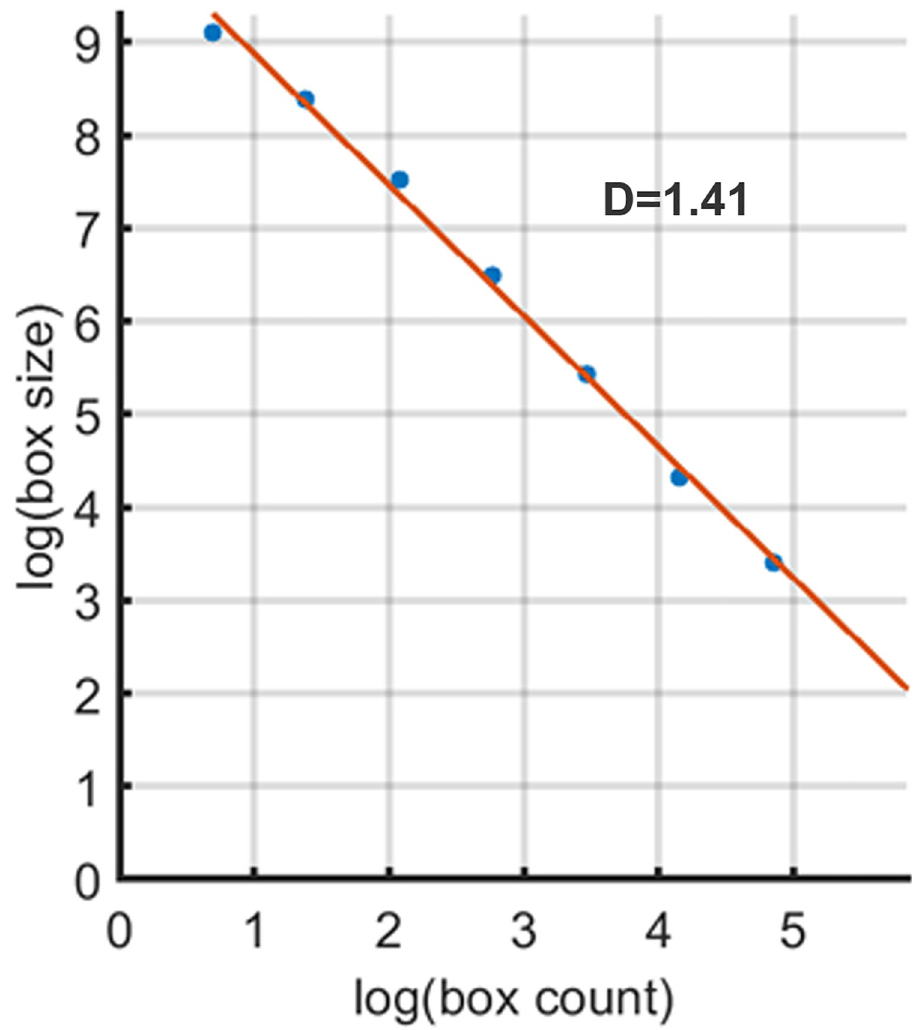
Fig 2. The representative result of FD measurement. FD value (D = 1.41) of the cytoskeleton of the cell presented on (Fig 1A) was defined as the slope of the line that approximates data points of plotting box sizes against box counts in logarithmic